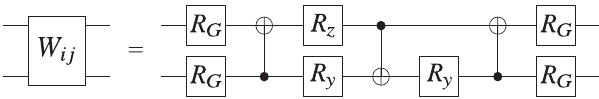
FIG. 16. Quantum circuit to implement an arbitrary unitary on two qubits. As shown in Ref. [63], W is universal (in that it can ij implement any two-qubit gate), and optimal (in that it contains the minimal number of CNOT gates and parameters, i.e., three CNOT e − iZ θ 1 = 2 e − iY θ 2 = 2 e − iZ θ 3 = 2 is a gates and 15 parameters). Here, R G ¼ general single-qubit rotation, and R μ with μ ∈ f y; z g is a single- qubit rotation of the Bloch sphere about axis μ